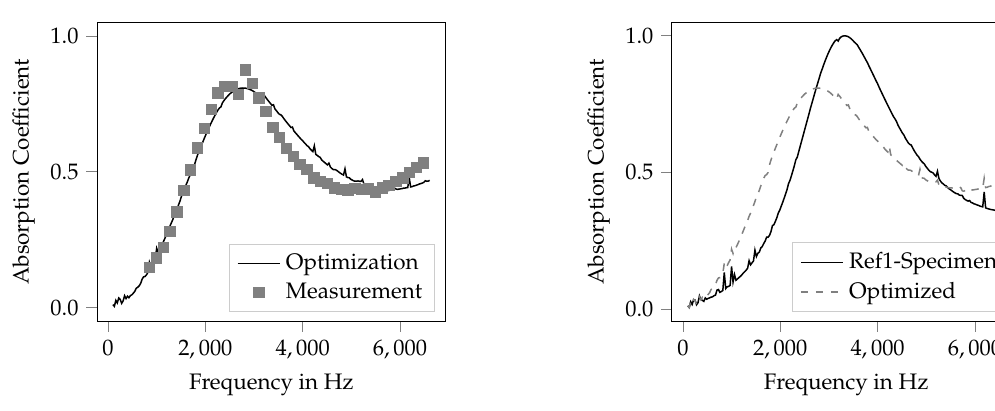
Figure 8. Result of the material optimization by variation of the layer